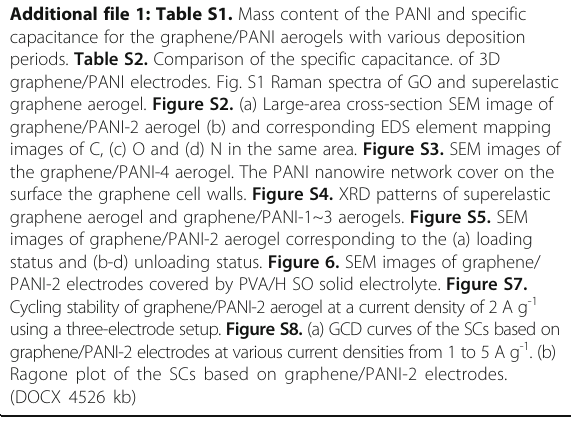
Additional file Additional file 1: Table S1. Mass content of the PANI and specific capacitance for the graphene/PANI aerogels with various deposition periods. Table S2. Comparison of the specific capacitance. of 3D graphene/PANI electrodes. Fig. S1 Raman spectra of GO and superelastic graphene aerogel. Figure S2. (a) Large-area cross-section SEM image of graphene/PANI-2 aerogel (b) and corresponding EDS element mapping images of C, (c) O and (d) N in the same area. Figure S3. SEM images of the graphene/PANI-4 aerogel. The PANI nanowire network cover on the surface the graphene cell walls. Figure S4. XRD patterns of superelastic graphene aerogel and graphene/PANI-1~3 aerogels. Figure S5. SEM images of graphene/PANI-2 aerogel corresponding to the (a) loading status and (b-d) unloading status. Figure 6. SEM images of graphene/ PANI-2 electrodes covered by PVA/H SO solid electrolyte. Figure S7. Cycling stability of graphene/PANI-2 aerogel at a current density of 2 A g -1 using a three-electrode setup. Figure S8. (a) GCD curves of the SCs based on graphene/PANI-2 electrodes at various current densities from 1 to 5 A g -1 . (b) Ragone plot of the SCs based on graphene/PANI-2 electrodes. (DOCX 4526